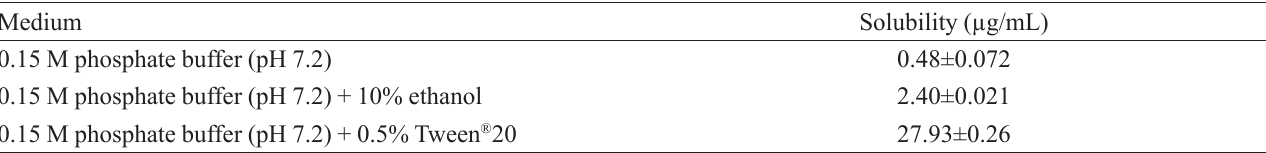
TABLE II - Saturation solubility of quercetin in different media